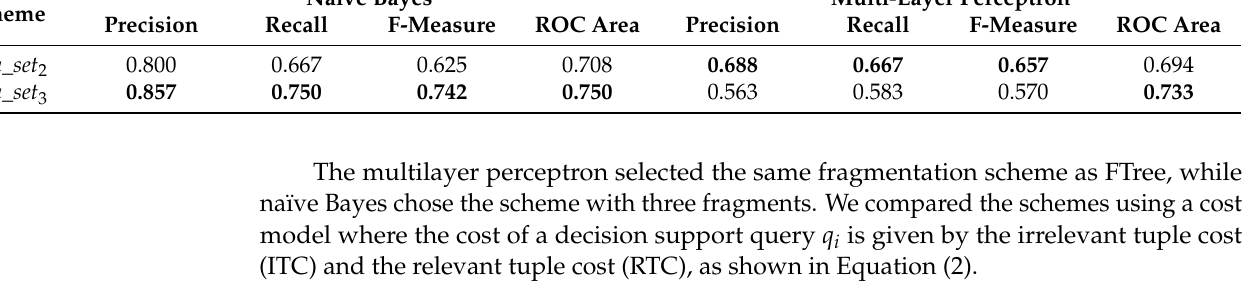
Figure 11. Decision tree for 2 fragments found by FTree for the second experiment.